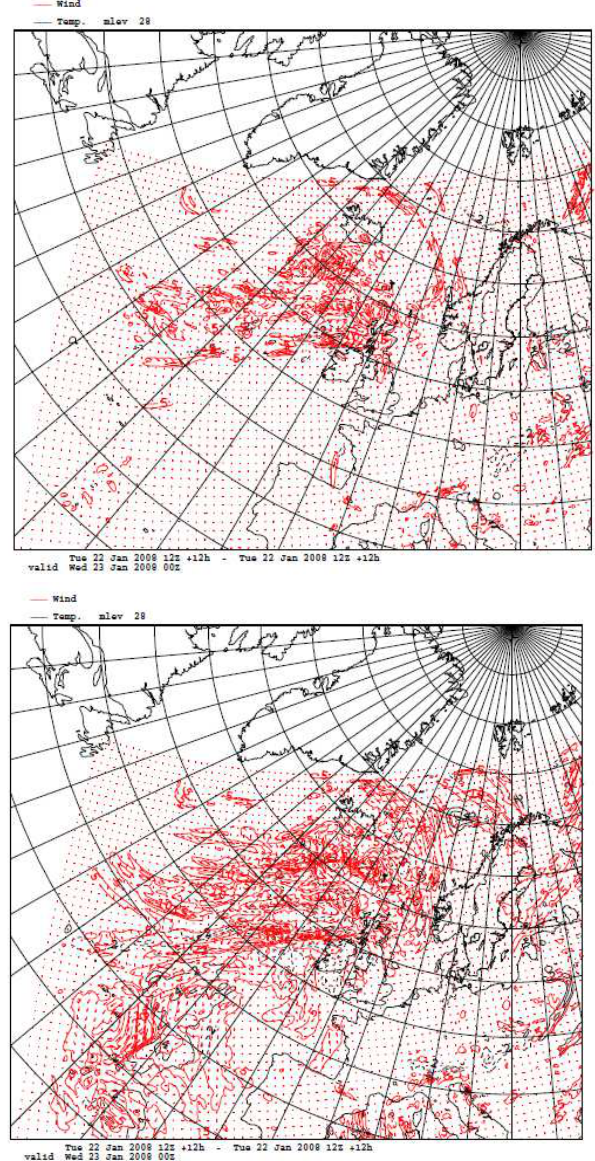
Fig. 16. Temperature and wind ensemble forecast perturbations at model level 28 for ensemble member 5, 22 January 2008 12:00UTC + 12h. ETKF based perturbations (upper panel) and EDA based perturbations (lower).